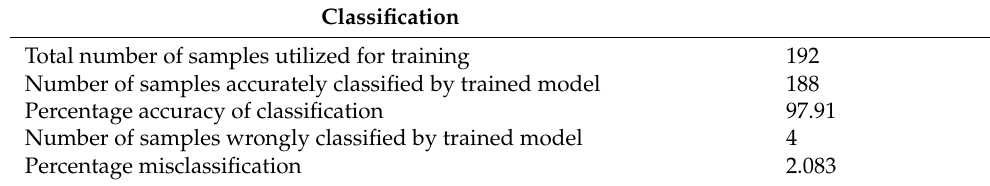
Table 4. Classification results summary considering training dataset.